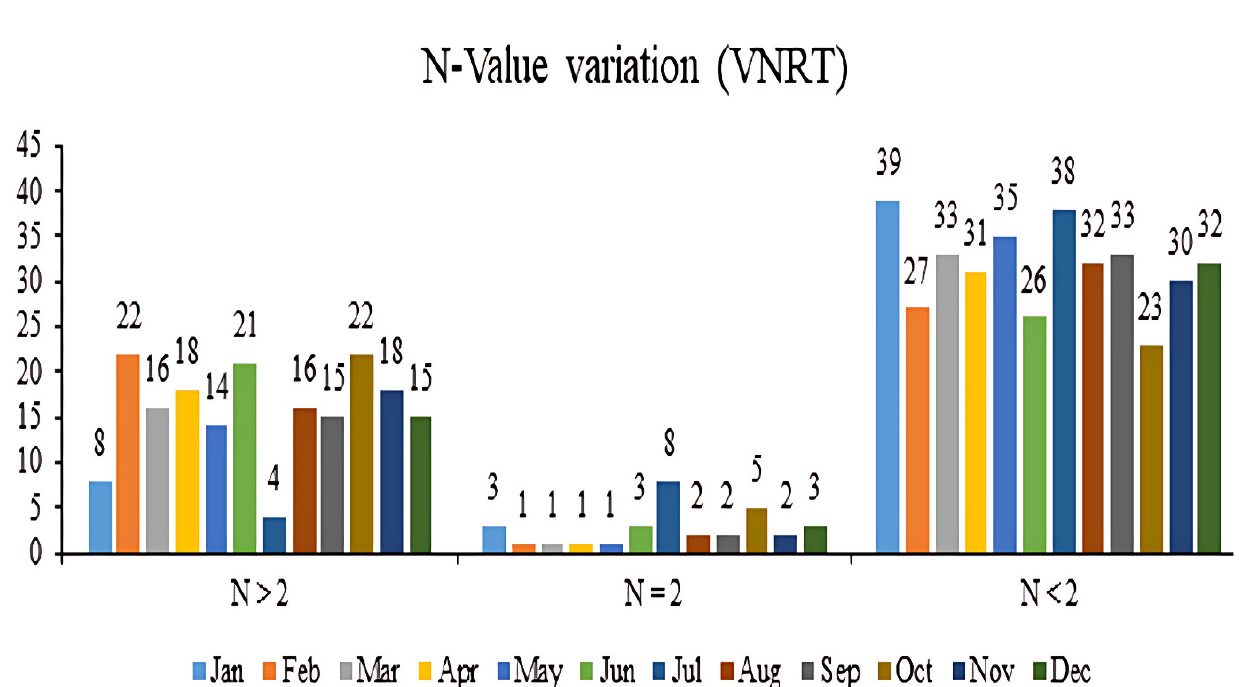
Figure 4. Annual Homogeneity Test.